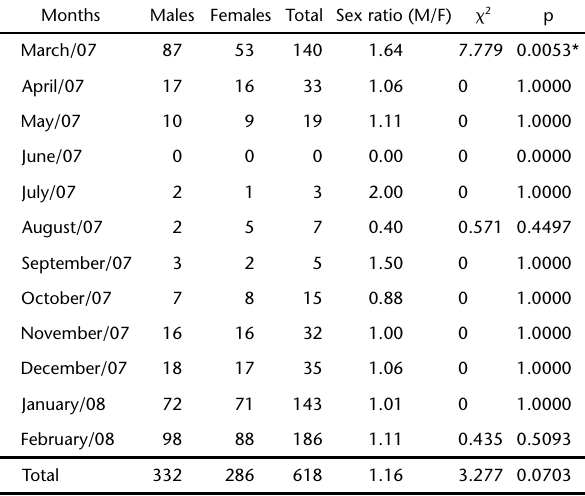
Table V. Sex ratio by month obtained for the population of Callinectes ornatus in the Estuary-Bay Complex of São Vicente. Months